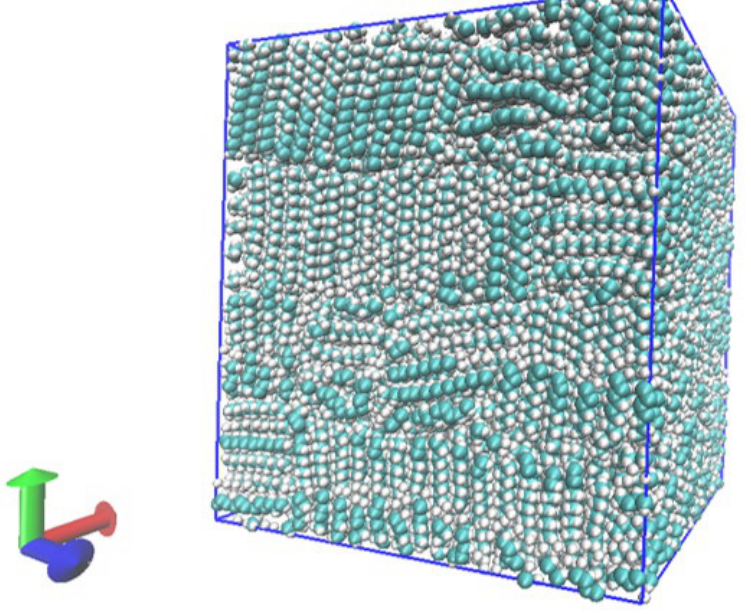
Figure 5. Snapshot of the crystallized molecules on the NA of case 2 at − 3.15 ◦ C and a simulation duration of 7.2 ns.